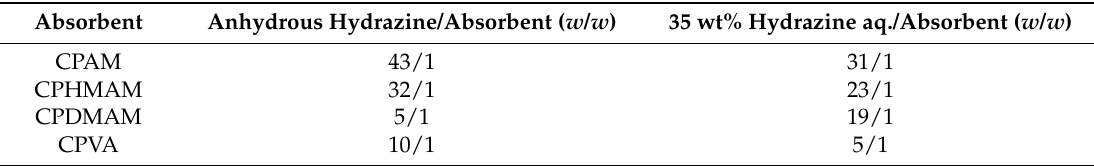
Table 2 . Saturated amounts of anhydrous hydrazine and 35 wt% hydrazine aq. absorbed by cross-linked absorbents (cross-linker contents = 3 mol%).